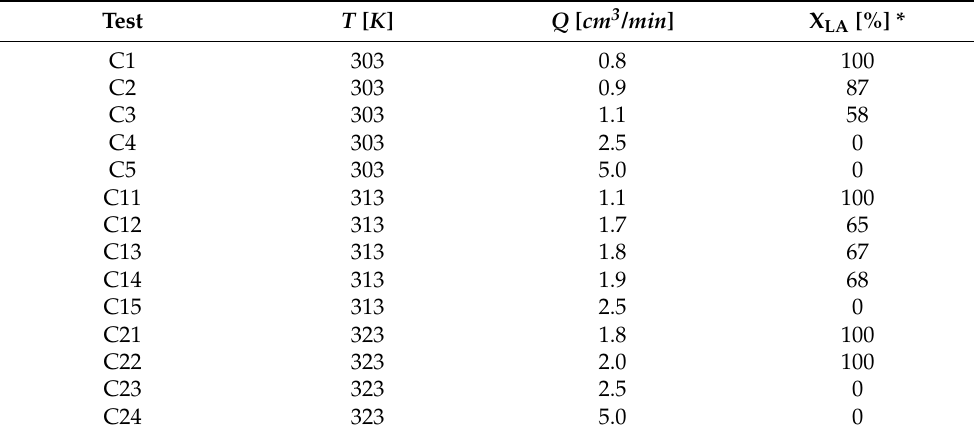
Table 4. LA conversions achieved at different operative conditions during the chromatographic re- actor tests with LA 6 M pulses.